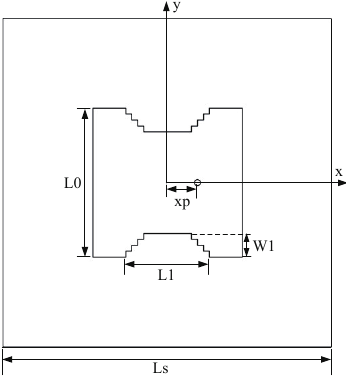
Figure 14. Antenna structure.